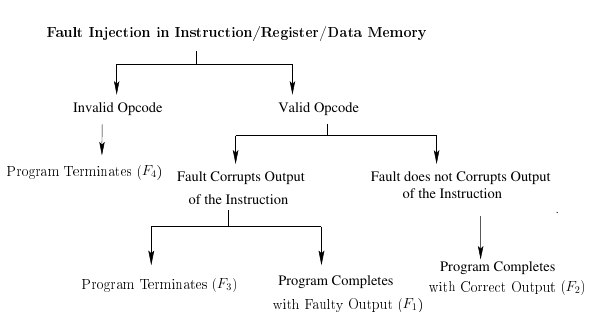
Figure 4: Manifestation of a fault injected in instruction or data may either alter or leave unaltered the instruction output. It may also result in a program termination.